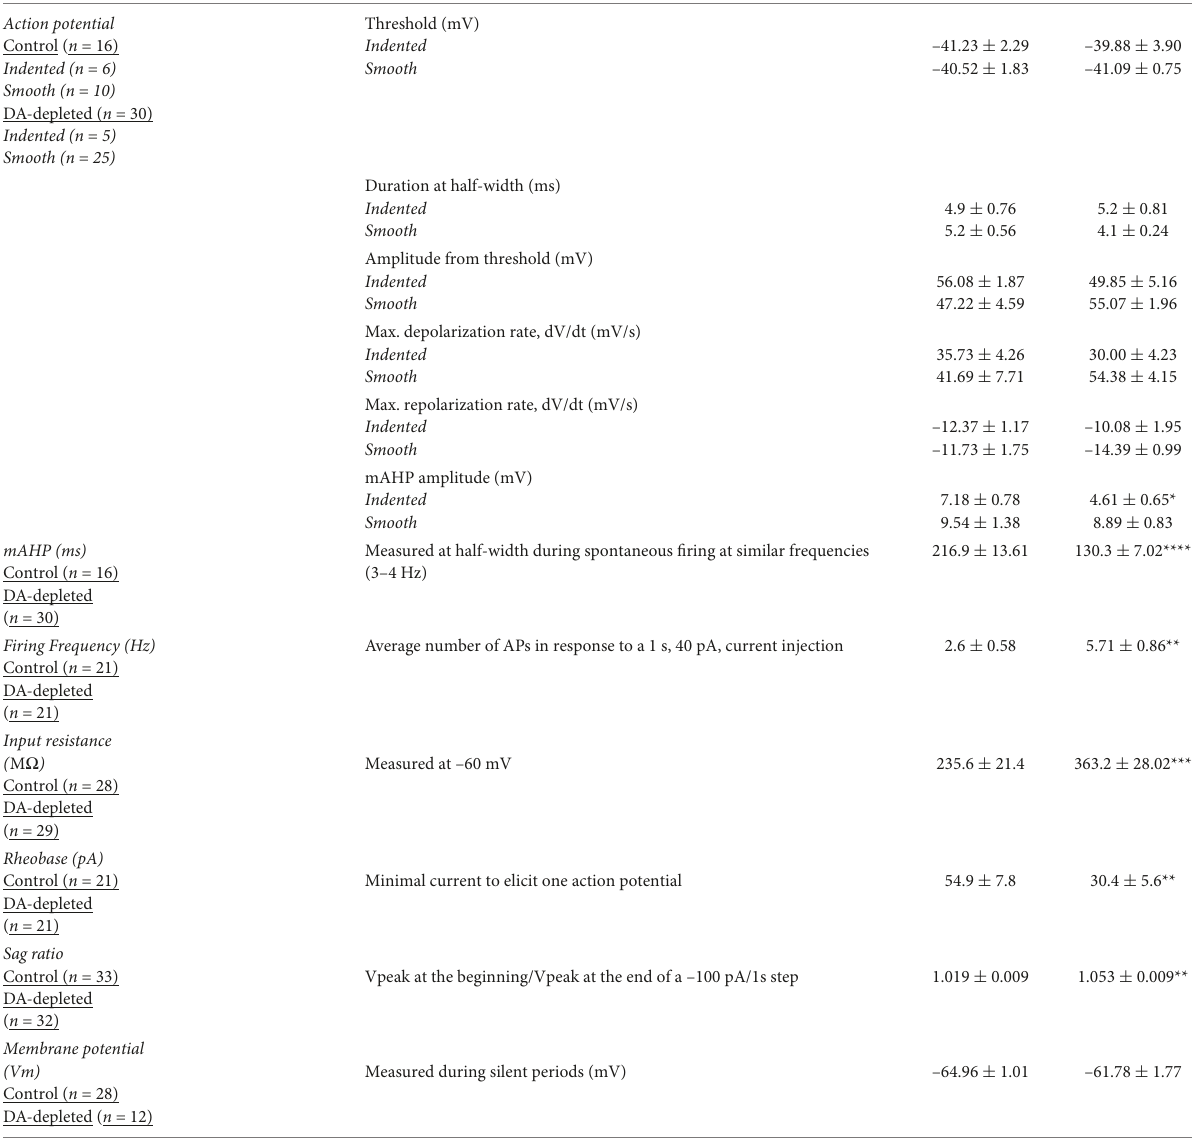
TABLE 1 Changes in intrinsic properties of CINs after